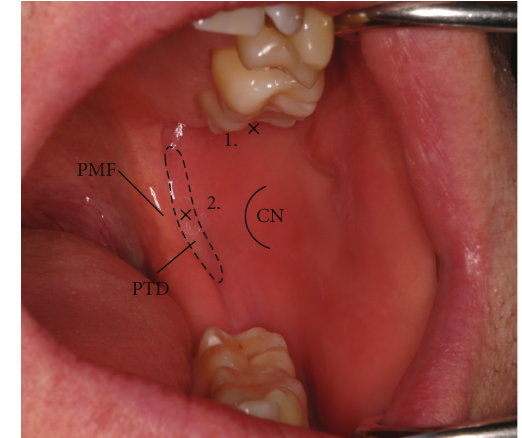
Figure 3: Intraoral photograph of the left side of the oral cavity showing the injection sites for di ff erent mandibular block techniques. The pterygotemporal depression exists between the pterygomandibular fold and coronoid notch and represents the area where a direct or indirect IANB is administered in the mediolateral plane. The height at which this block is given is approximately the level of the coronoid notch. In contrast, the Gow-Gates mandibular block is administered at a much higher level. The mesiopalatal cusp of the upper second molar determines the height of the injection while the site in the mediolateral plane is the area of tissue just posterior to the upper second or third molar (PTD: pterygotemporal depression, PMF: pterygomandibular fold, CN: coronoid notch, 1: area where a direct/indirect IANB would be administered, 2: area where a Gow-Gates mandibular block would be